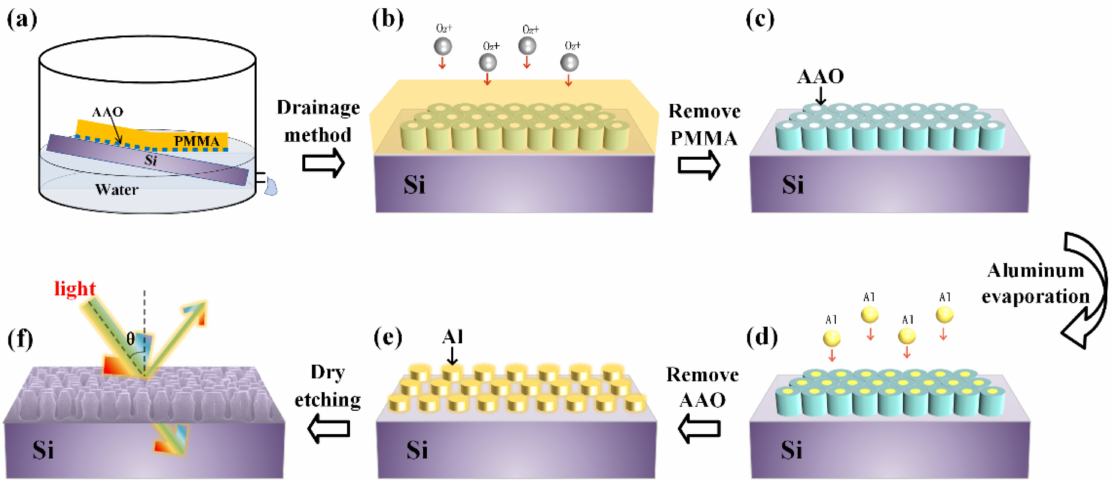
Figure 1. The schematic diagram of the AAO thin film-based pattern replication flow: ( a , b ), de- positing method. ( b , c ), PMMA removal by oxygen dry etching. ( c , d ), aluminum evaporation. ( d , e ), remove AAO. ( e , f ), dry etching by using the aluminum etching